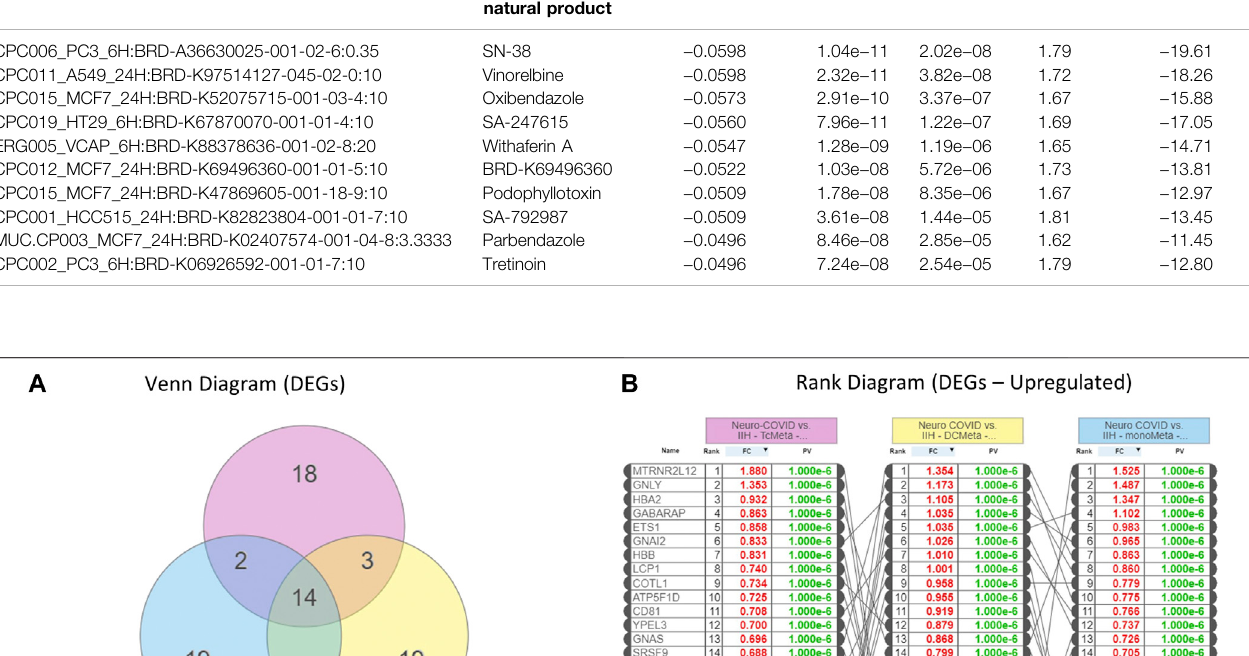
TABLE 6 | Natural products and drugs with opposite molecular signatures based on L1000FWD web-based tool for querying gene expression signatures (SARS-CoV-2- NHBE vs. Mock-NHBE) against signatures created from human cell lines treated with over 20,000 small molecules and drugs for the LINCS project. Signature ID